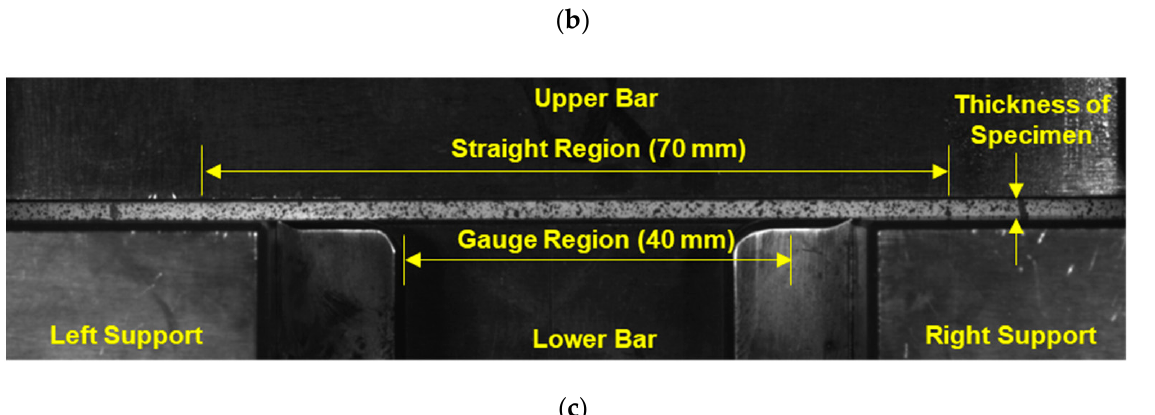
Figure 2. Specimen for tension-compression testing: ( a ) arrangement of the specimen, bar, and jaws, ( b ) dimensions, and ( c ) side surface for DIC measurement. Friction coefficients were measured using a cut specimen with only one grip region. The grip region on the left side of the specimen was cut so that the specimen can slide between the anti-buckling bars with the movement of the grip on the right. The friction coefficient was calculated as the half of the force measured at the jaws divided by the applied side force. Figure 3 shows the measured friction coefficient at various